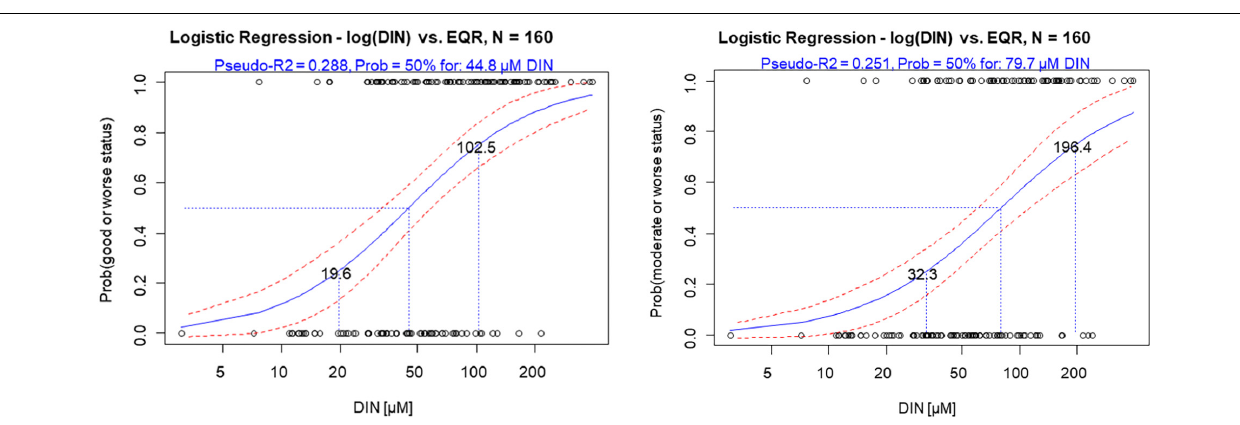
FIGURE 4 | Binomial logistic regression of DIN on probability of being at good or worse status (left) and at moderate or worse status (right) (normalized EQRs used), for the NEA11 common type. Lines show potential boundary values at different probabilities of being in good or worse status and moderate or